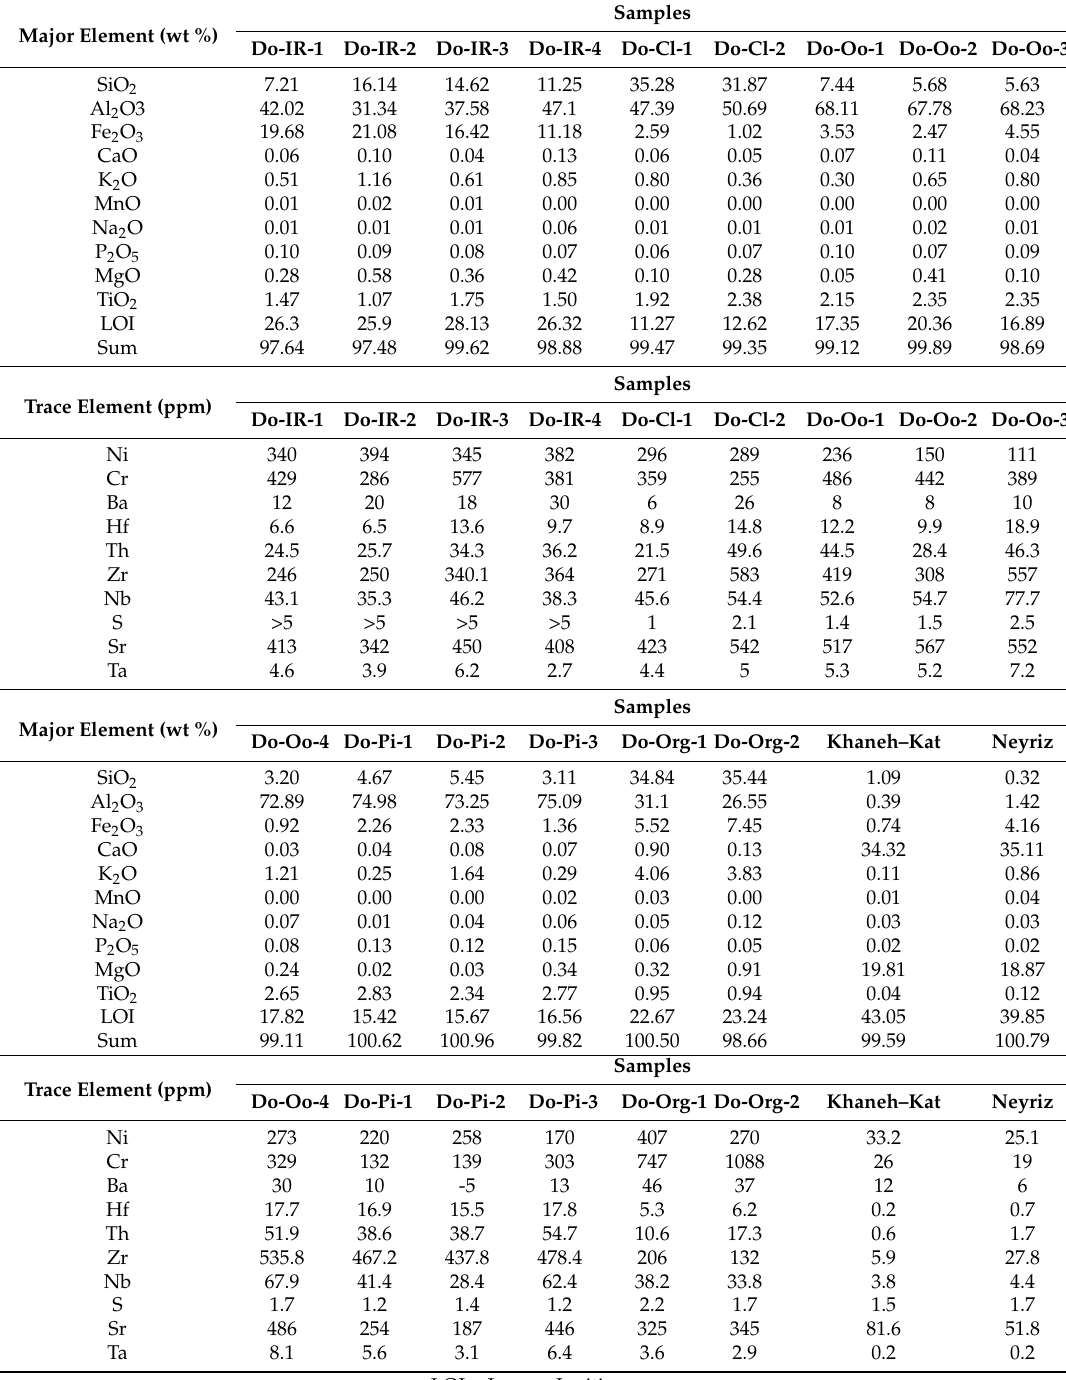
Table 2. Major and trace element compositions of samples from the Dopolan deposit, Khaneh–Kat and Neyriz Formations. Detection limits for major and trace elements are 0.002% and 0.05 ppm,